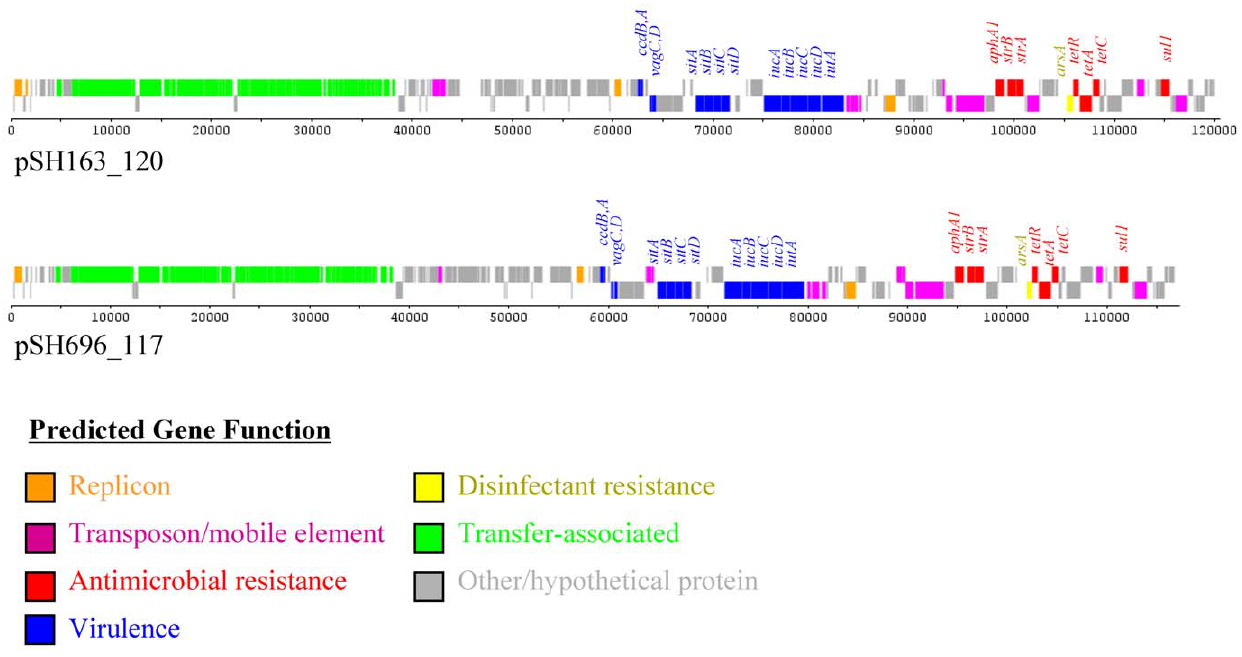
Figure 2. Linear representation of the IncFIB plasmids. For each of the plasmid diagrams the predicted functions of genes are identified by the colors indicated in the figure key. The predicted virulence, antimicrobial and disinfectant/heavy metal resistance genes are identified in plasmids pSH163_120 and pSH696_117.